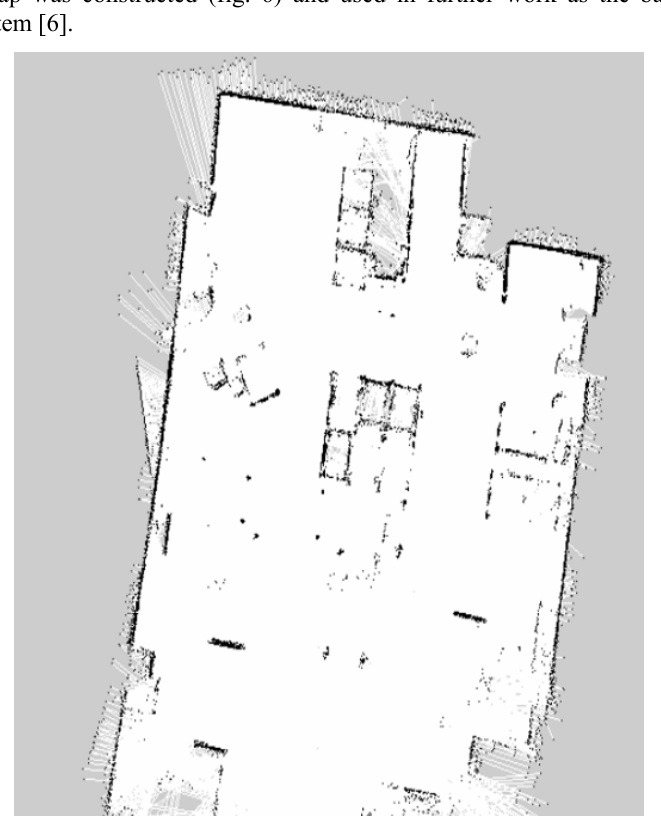
Fig. 6. Example of GMapping package